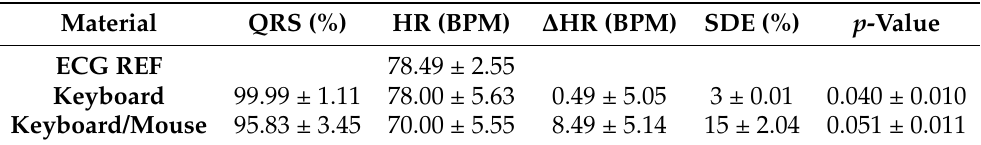
Table 2. Comparative analysis of the heart rate values determined for the ECG time series obtained with the reference sensor (ECG REF) and with the experimental sensor (ECG EXP) in Keyboard or